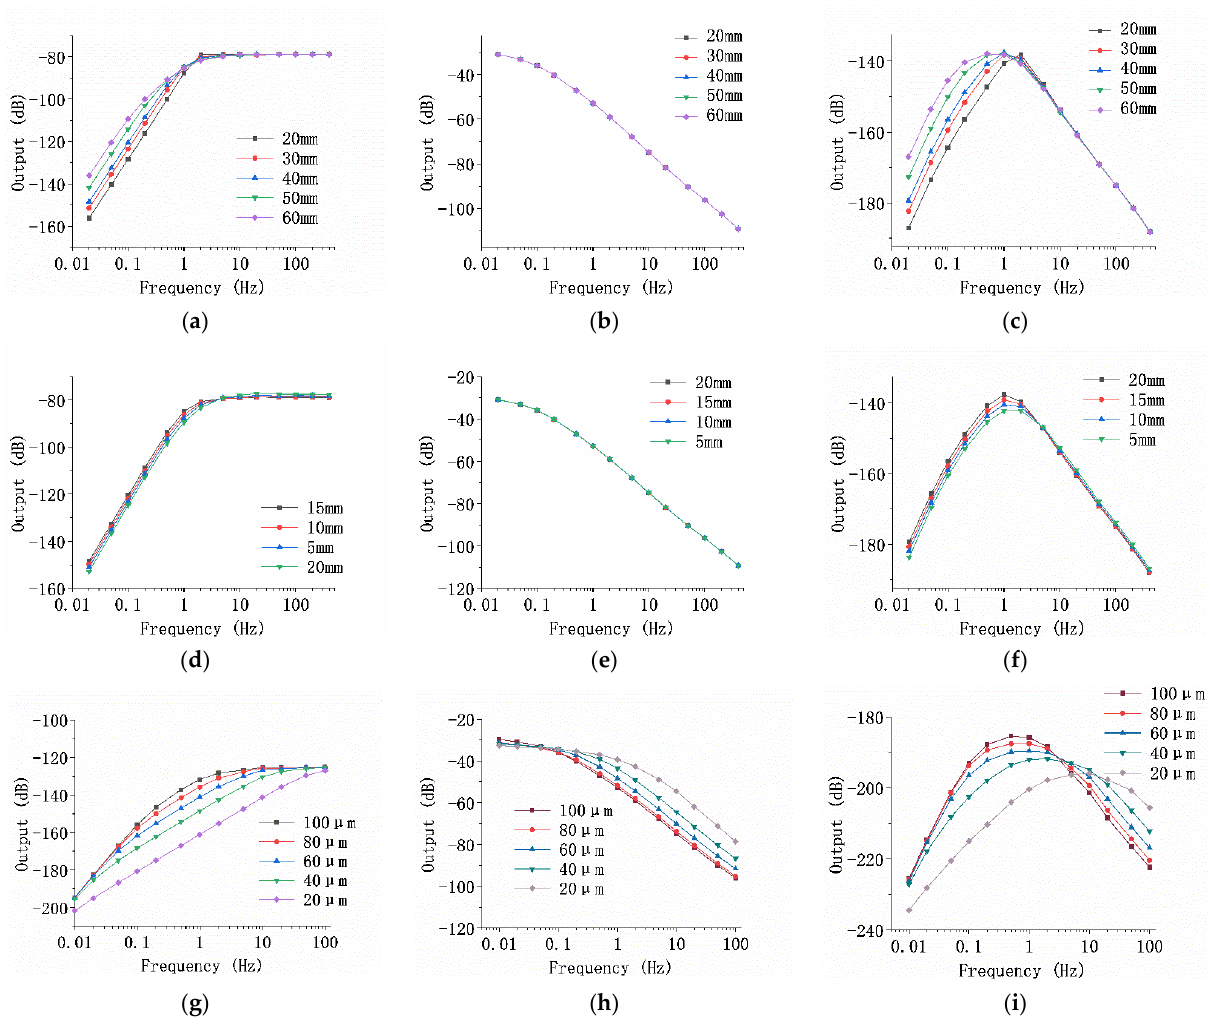
Figure 3. Simulation results of sensor optimization. ( a ) The amplitude–frequency curve of the simulation output of the vibration module when the diameter of the rubber membrane was 20–60 mm; ( b ) the amplitude–frequency curve of the simulation output of the electrochemical module when the diameter of the rubber membrane was 20–60 mm; ( c ) the amplitude–frequency curve of the overall output of the simulation model when the diameter of the rubber membrane was 20–60 mm; ( d ) the amplitude–frequency characteristic curve of the simulation output of the vibration module when the length of the flow channel was 5–20 mm; ( e ) the amplitude–frequency characteristic curve of the simulation output of the electrochemical module when the length of the flow channel was 5–20 mm; ( f ) the amplitude–frequency characteristic curve of the overall output of the simulation model when the flow channel length was 5–20 mm; ( g ) the amplitude–frequency curve of the simulation output of the vibration module when the diameter of the flow holes was 20–100 μ m; ( h ) the amplitude–frequency characteristic curve of the simulation output of the electrochemical module when the diameter of the flow holes was 20–100 μ m; ( i ) the amplitude–frequency characteristic curve of the overall output of the simulation model when the diameter of the flow holes was 20–100 μ m. Figure 3a–c shows the simulation results of the effects of the diameter of the rubber membrane. When other factors remained the same, the diameter of the rubber membrane mainly affected low ‐ frequency performance. The low ‐ frequency attenuation speed de ‐ creased as the diameter of the rubber membrane increased, leading to better low ‐ fre ‐